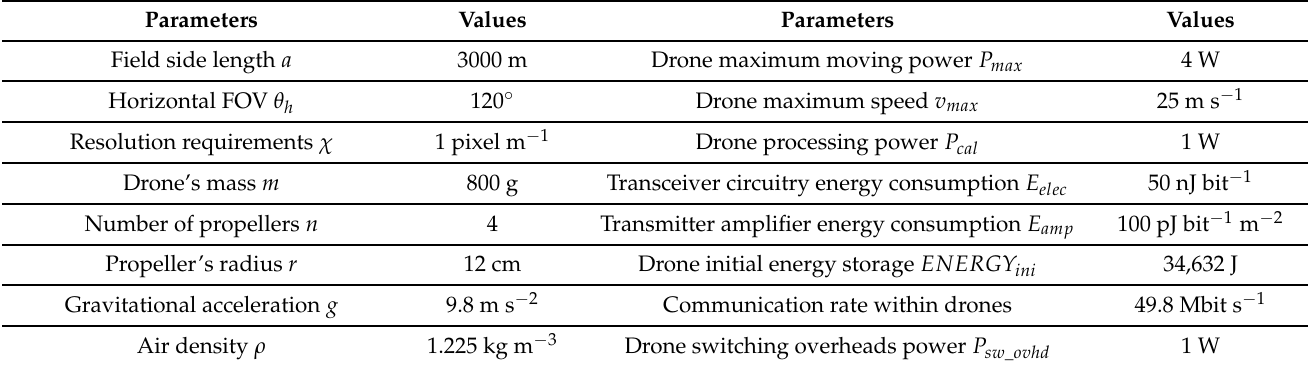
Table 1. The simulation